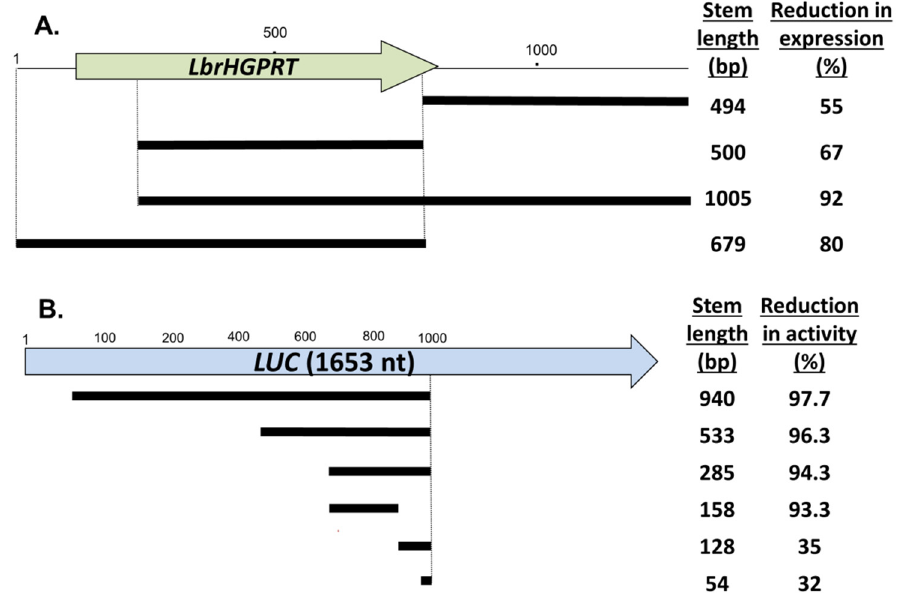
Figure 2. The effect of stem length on RNAi activity. ( A ) Targeting the endogenous HGPRT . Various stem length HGPRT StL constructs were transfected into L. braziliensis, and HGPRT expression assessed in two colonies by Western blot with anti-HGPRT antisera and anti-H2A antisera for normalization (Supplementary Figure S1). The percent expression relative to WT Lbr is shown. ( B ) Targeting an introduced luciferase reporter. Various stem length LUC StL constructs were transfected into an Lbr line expressing LUC (Section 2.2). Luciferase activity was measured in triplicate and the percent reduction in activity calculated relative to the parental Lbr -LUC-expressing line.